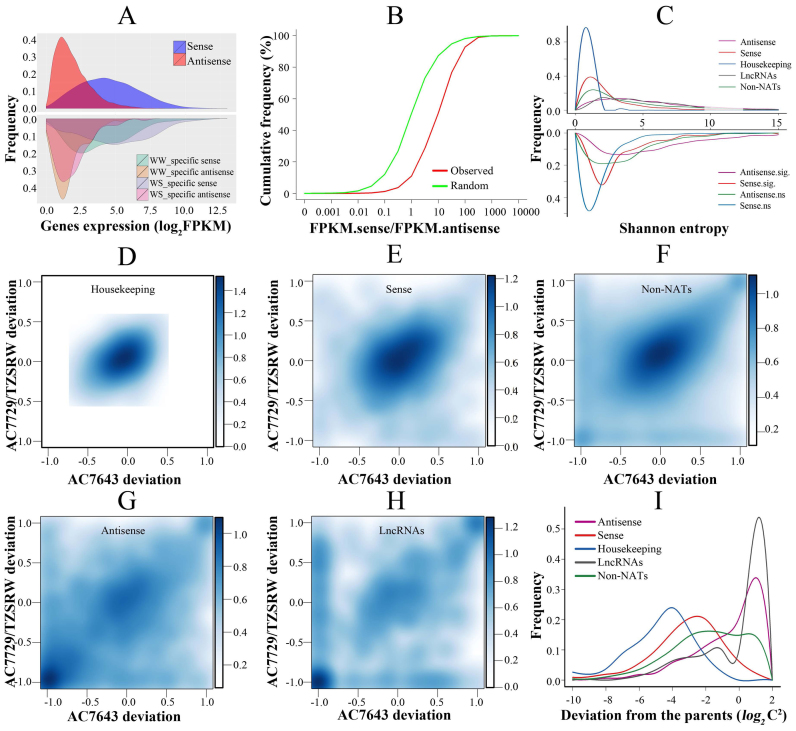
Expression and inheritance patterns of NAT pairs. (A) Density distribution for expression levels of sense and antisense transcripts, as well as WW-specific and WS-specific sense and antisense transcripts. Kinds of transcripts are as indicated. WW: well water; WS: water stress. (B) Cumulative frequency distribution of sense and antisense transcripts expression ratios. (C) Density distribution of Shannon entropy estimates of NATs, sense transcripts, housekeeping genes, lncRNAs and non-NATs, as well as antisense and sense transcripts whose response to drought was significant (sig.) or nonsignificant (ns). A color code is displayed in the top right corner and bottom right corner, respectively. (D–H) Two-dimensional density estimation of gene expression patterns in two recombinant inbred lines compared with two parental lines for housekeeping genes, NAT pair sense transcripts, non-NATs (non-housekeeping genes), NATs and lncRNAs, respectively. The x-axis and y-axis represent the gene expression-level deviation in recombination inbred lines relative to their parental lines, AC7643 and AC7729/TZSRW, respectively. (I) Distribution of expression-level deviations in recombination inbred lines relative to their parental lines, AC7643 and AC7729/TZSRW.